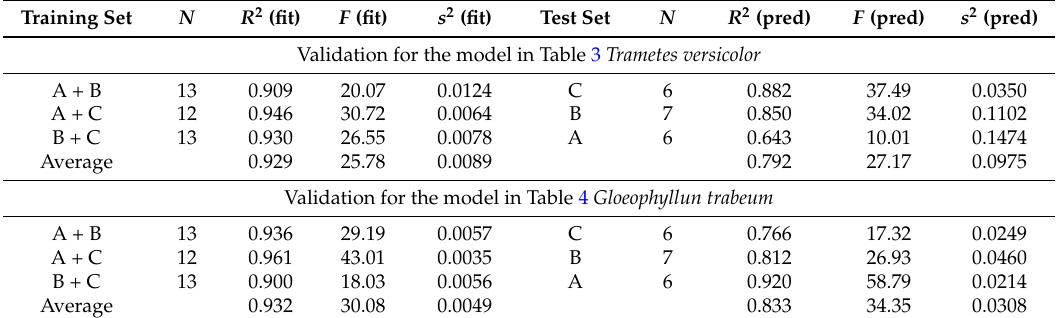
Table 6. Internal validation of the QSAR models of Trametes versicolor and Gloeophyllun trabeum